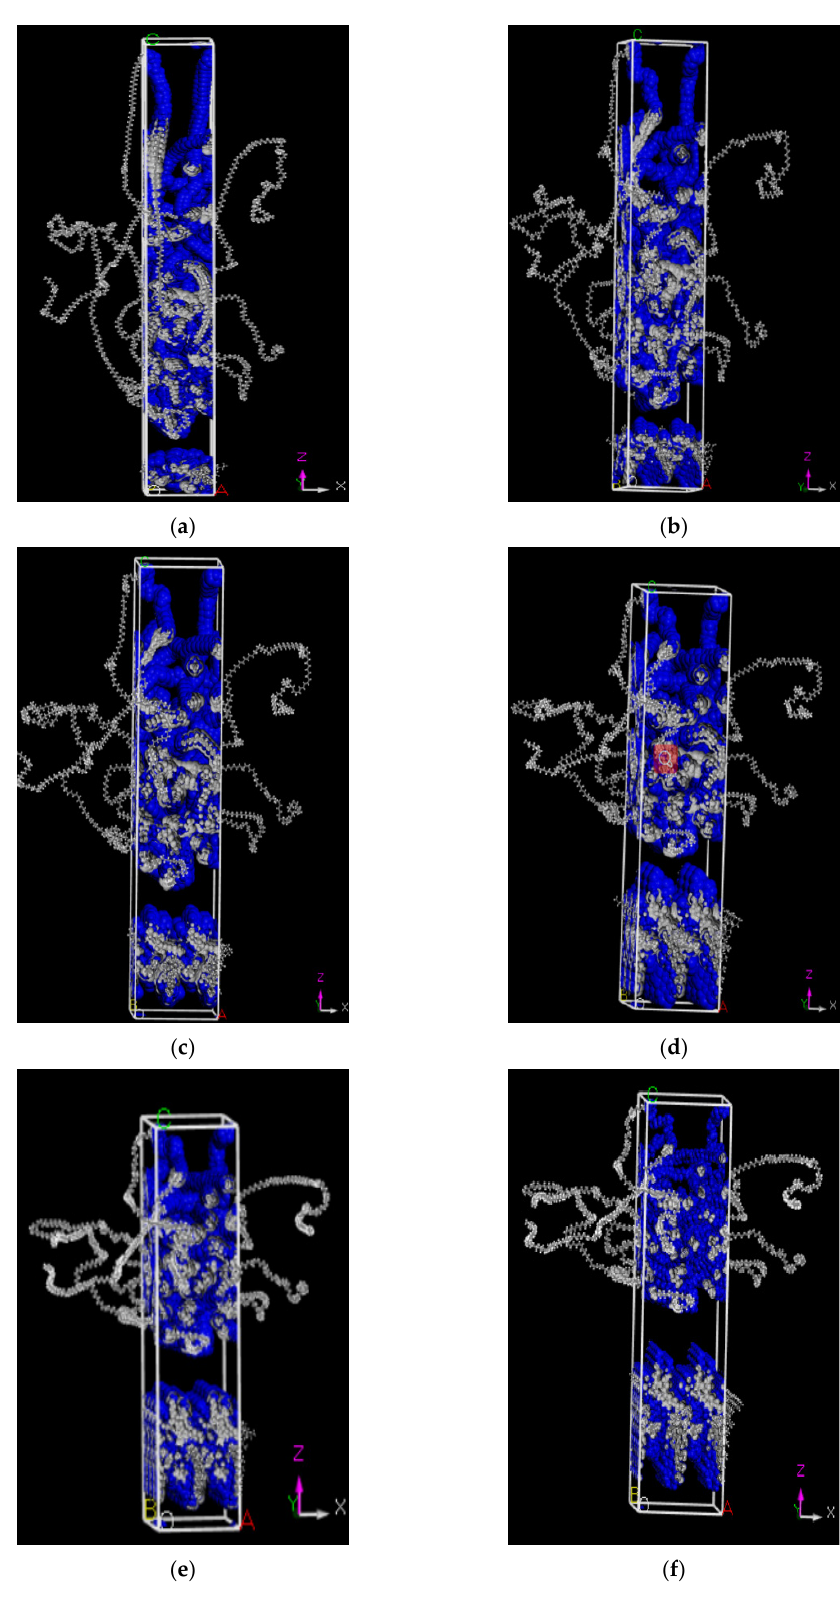
Figure 6. Free volume of waste plastic/rubber-modified asphalt with different percentages of waste polyethylene: ( a ) 0% waste PE; ( b ) 2% waste PE; ( c ) 4% waste PE; ( d ) 6% waste PE; ( e ) 8% waste PE; ( f ) 10% waste